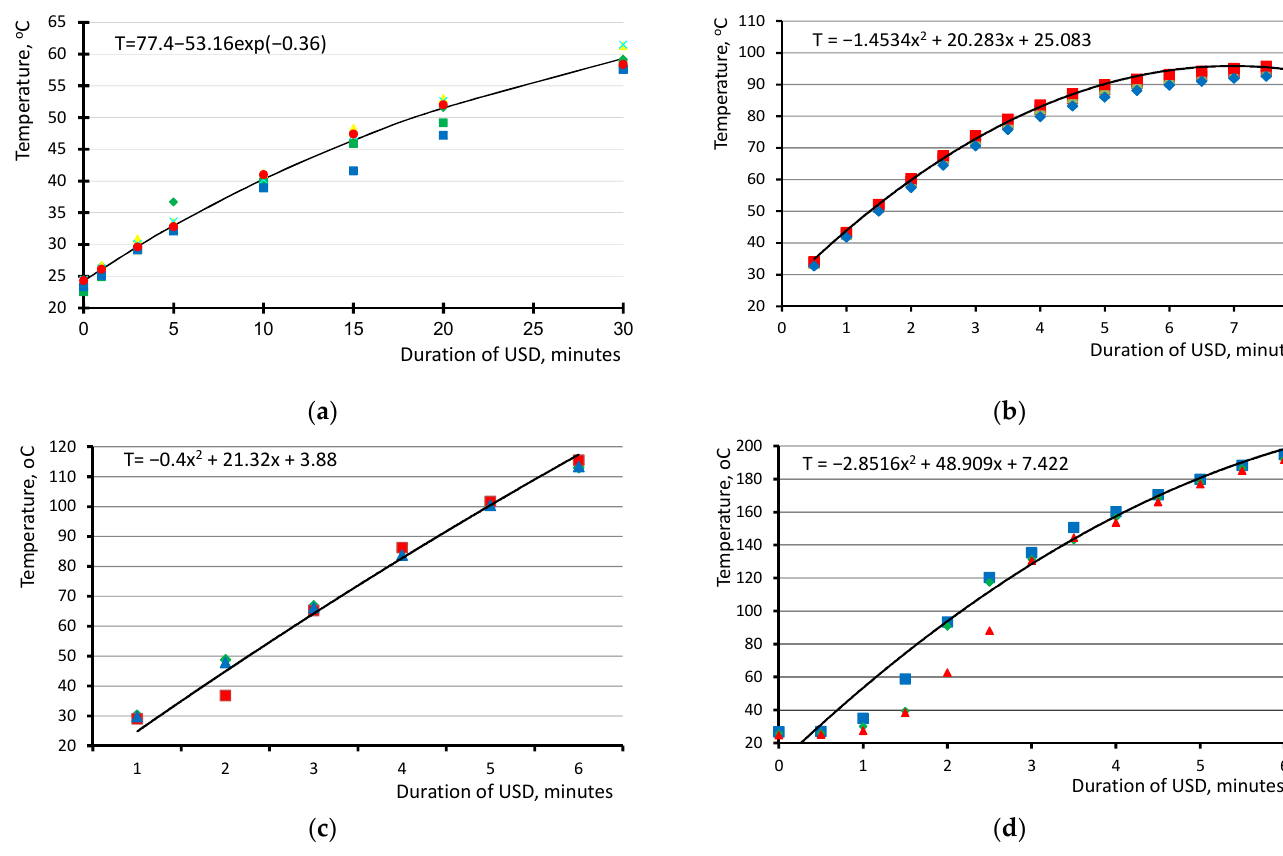
Figure 6. Dependence of solution (for each concentration in range) temperatures on the duration of USD: ( a ) aqueous (MFN and Sulfanol); ( b ) aqueous (CNPLUS and ViscoCrete 2100); ( c ) organic (MWCNT and industrial oil); ( d ) organic (MWCNT-MD and RSPE).